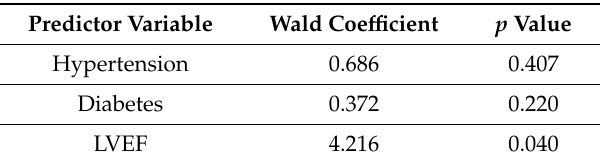
Table 3. Independent predictors of the iFR–FFR discrepancy.